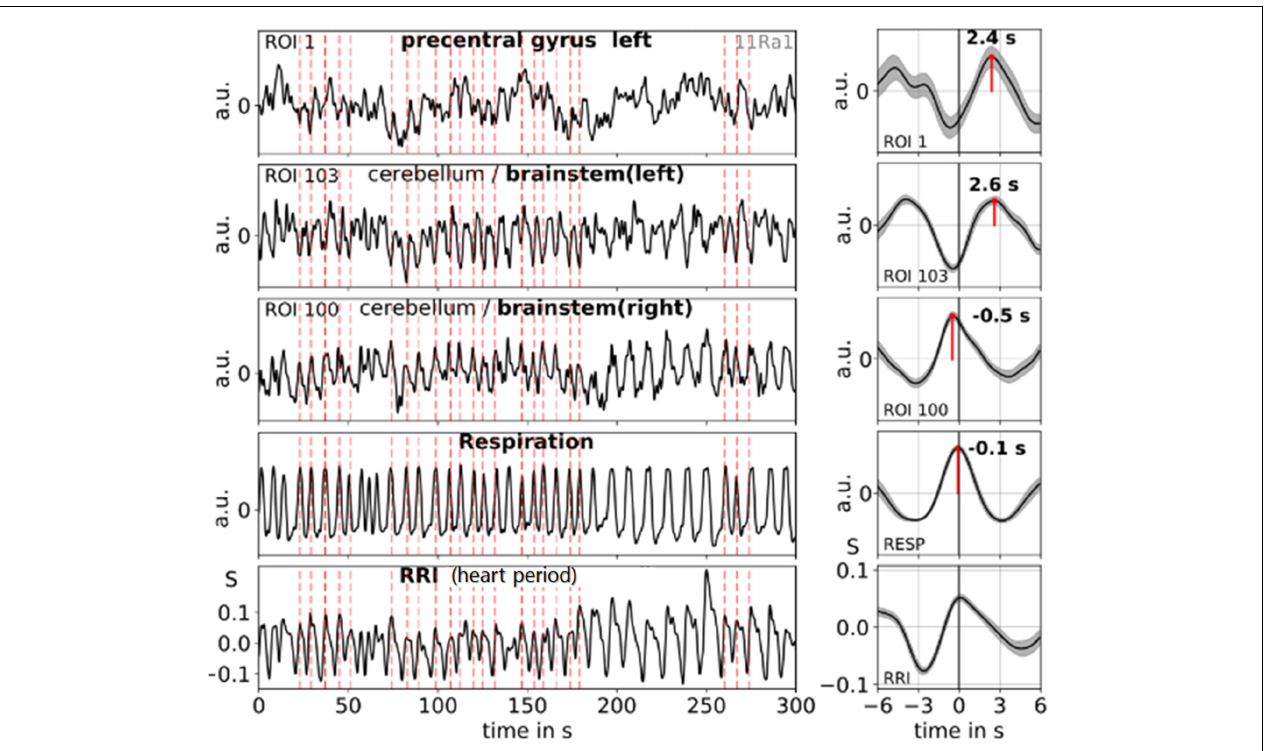
FIGURE 4 | Examples of ongoing BOLD, RRI and respiration signals (1:1 coupling) and corresponding averaged waves ( ± SE) for one subject (11R1) with dominant 0.10-Hz and 0.15-Hz oscillations. The vertical dashed lines indicate maxima (peaks) of waves with a period of ∼ 7 s of RRI oscillations used as trigger for averaging. Peaks of the averaged waves are indicated. Note, the peak difference between RRI and BOLD (ROI 103) waves of about 2.6 s, the coincidence of RRI, respiration and BOLD (ROI 100) waves and the cessation of respiratory sinus arrhythmia (nonRSA). Modified from Pfurtscheller et al. (2019).